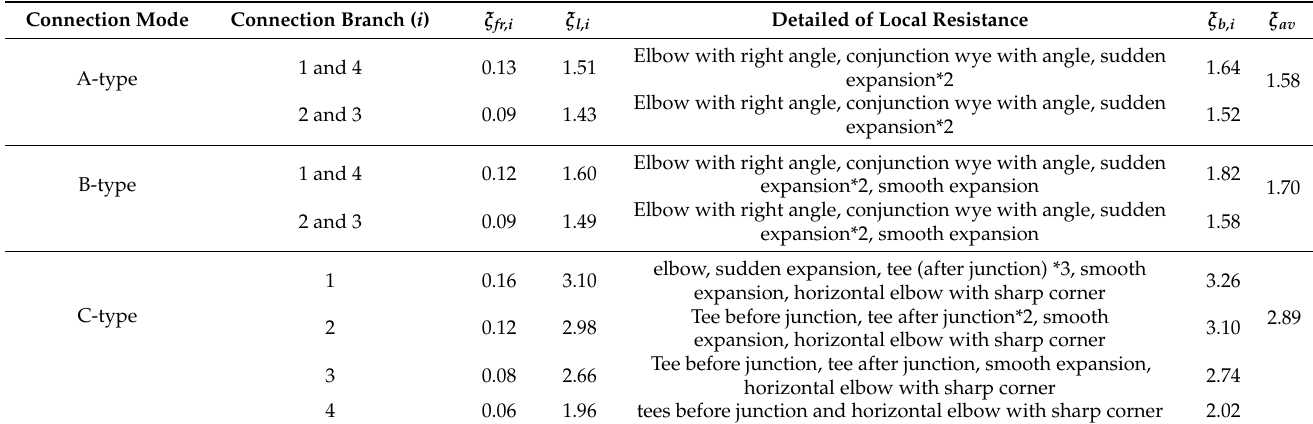
Table 2. Resistance coefficient